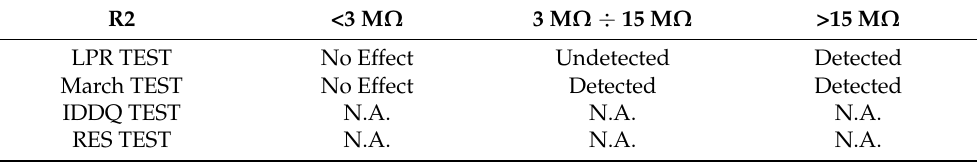
Table 6. Summary of the effectiveness of the different test methods with respect to R2.